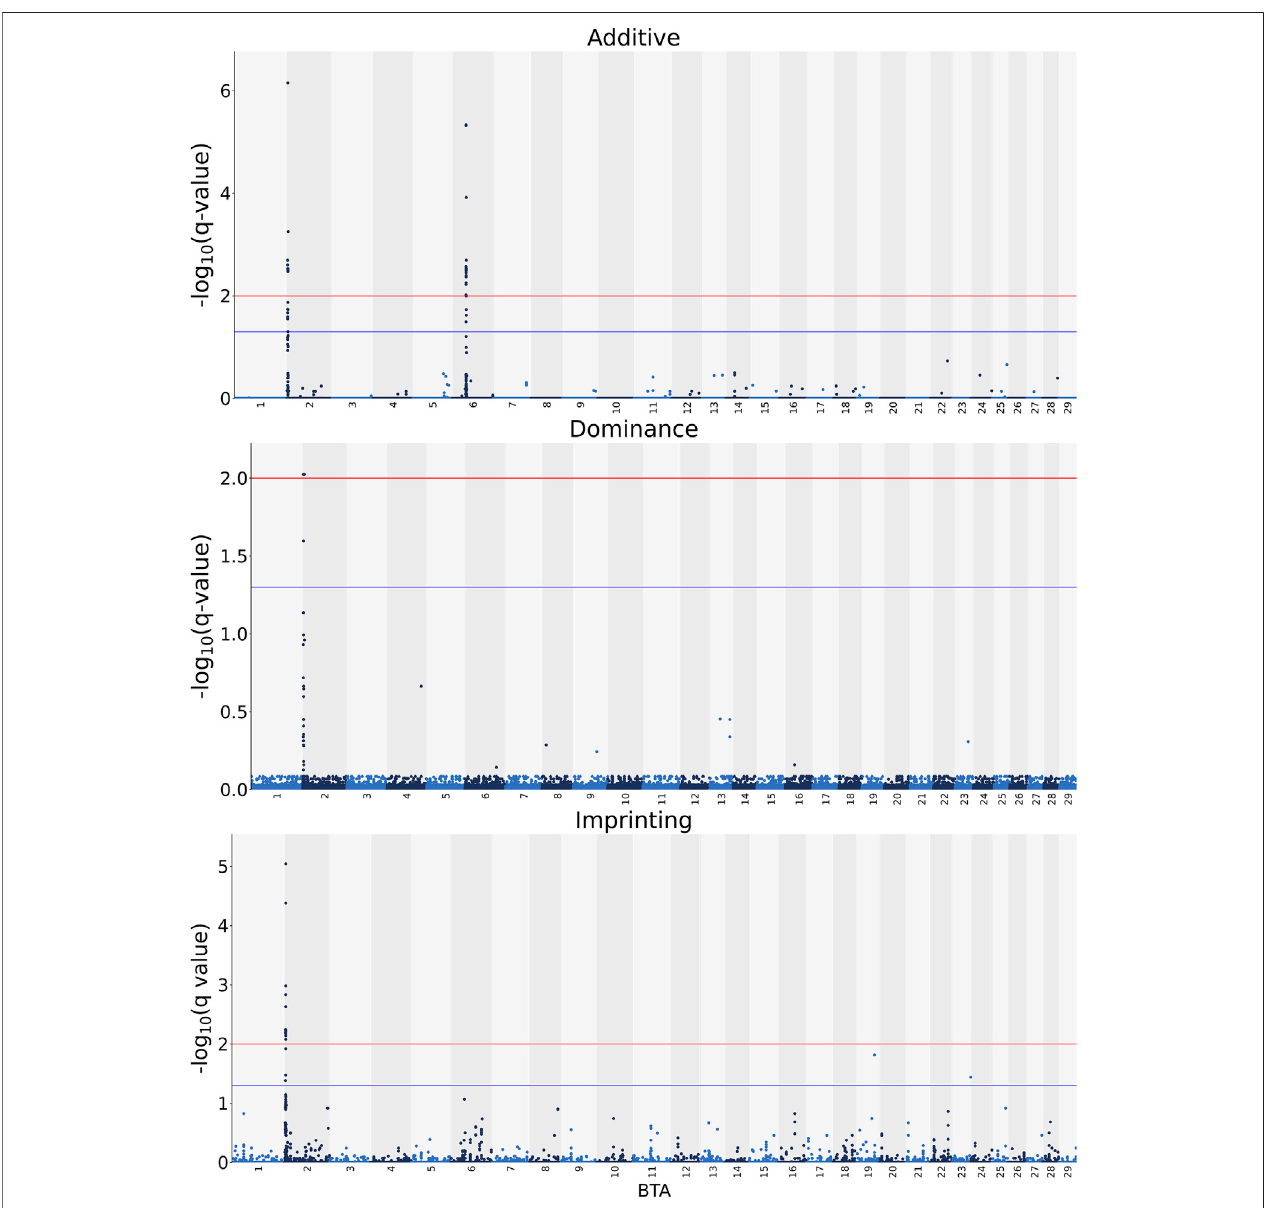
FIGURE 1 | Manhattan plots of the − log 10 (q values) for additive, dominance and imprinting associations with carcass weight from each Bos taurus (BTA) chromosome. Blue and red lines are the thresholds for suggestive (0.01 < q value ≤ 0.05) and signi fi cant (q values ≤ 0.01) SNPs, respectively.